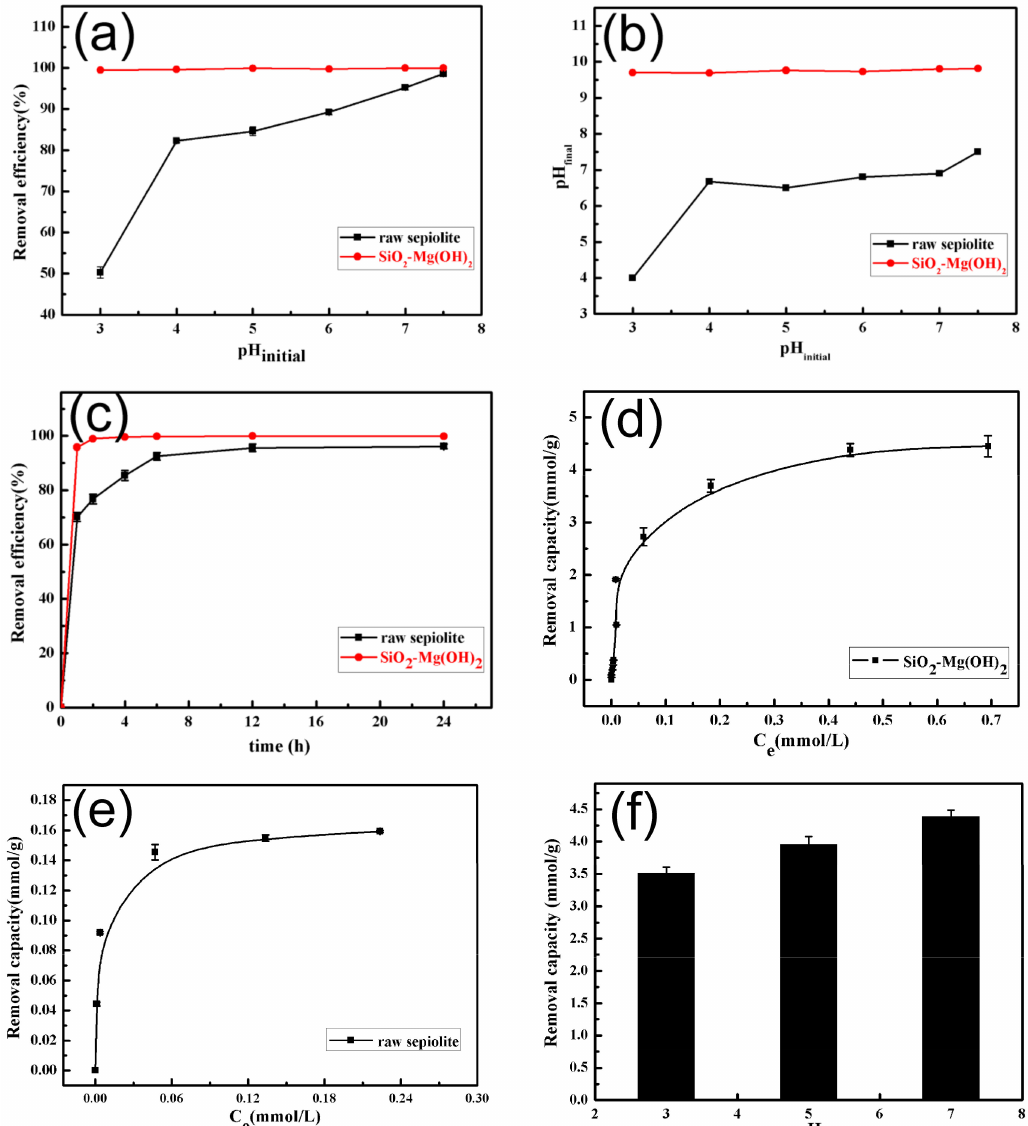
Figure 5. E ff ect of pH on the removal e ffi ciency of Gd(III) by raw sepiolite and the SiO 2 –Mg(OH) 2 nanocomposite ( a ); relationship between the initial and final pH of the adsorption system ( b ); e ff ect of contact time on the Gd(III) removal by raw sepiolite and the nanocomposite ( c ); removal capacity of the nanocomposite ( d ) and raw sepiolite ( e ) for Gd(III); removal capacity of the nanocomposite for Gd(III) at di ff erent pHs ( f